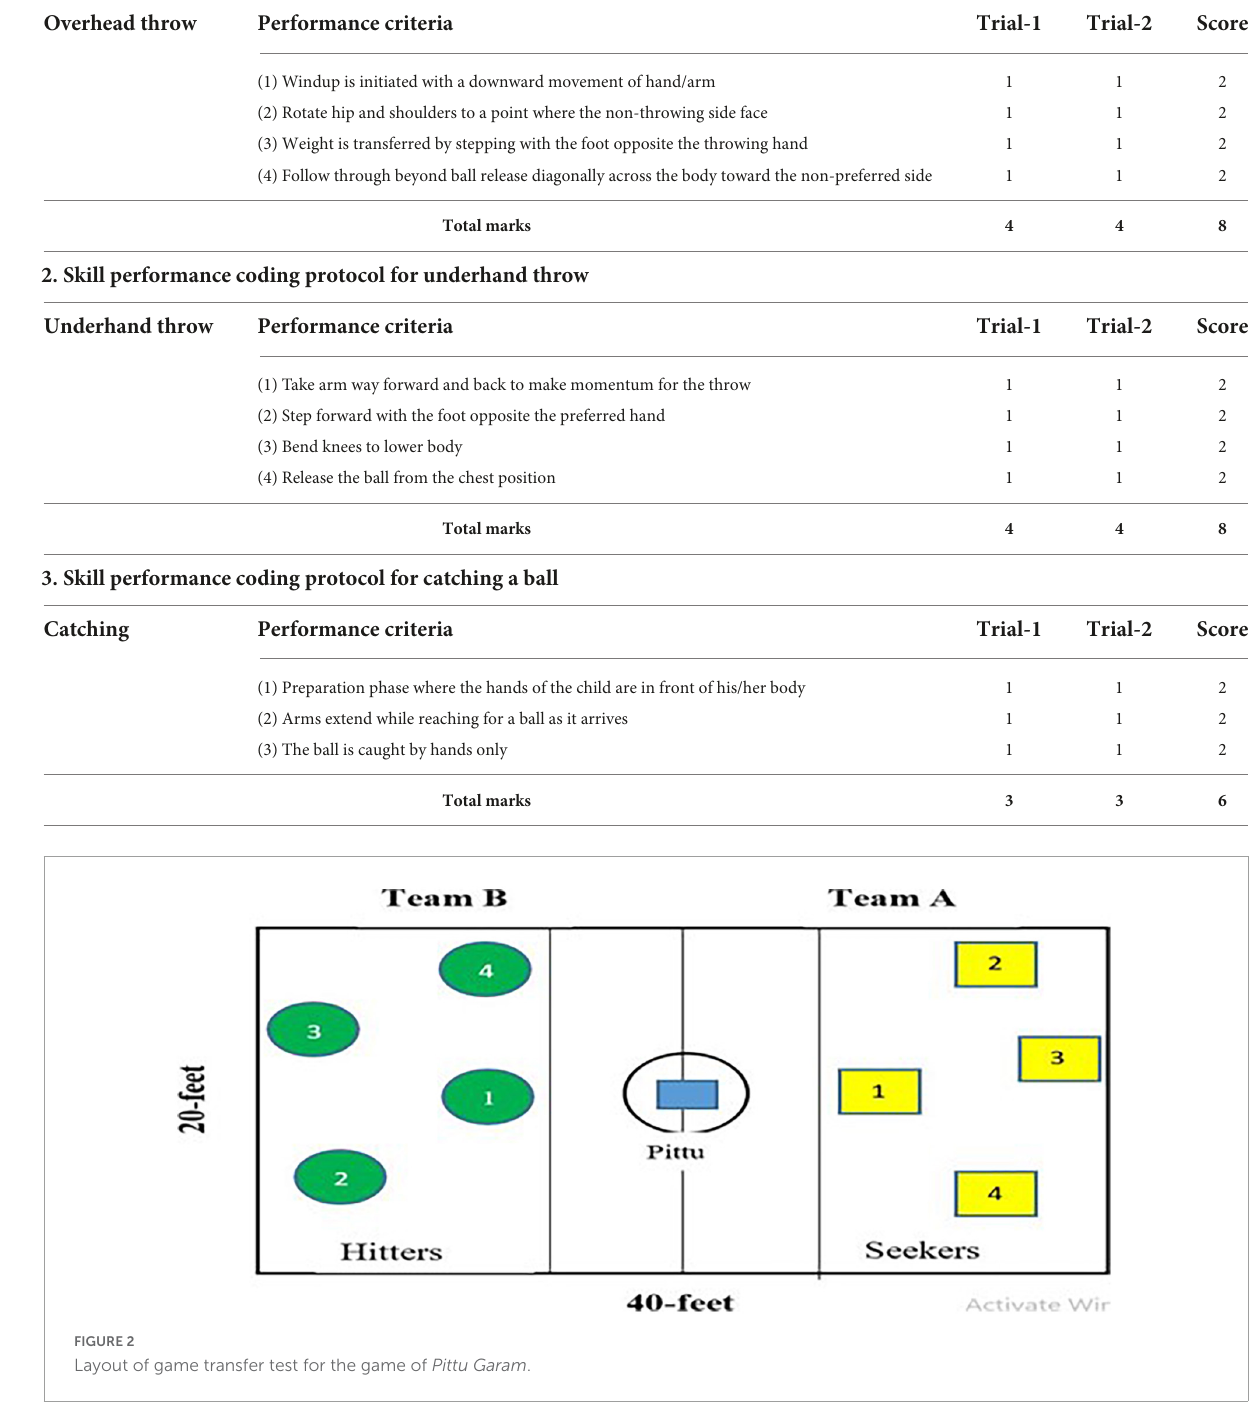
had a significantly lower score than the other three groups. = 0.637. Follow-up ANOVAs were performed p = 0.000, η 2 Partial For the post-test, there was a significant difference between at each time point. For the pre-test, there was a significant groups, F (3, 53.69) = 19.00, p = 0.000, η 2 difference between groups at the start of the experiment, = 0.214. The GB group The R group (Mean = 33.96, SD = 2.19) had F (3, 99) = 8.959, p = 0.000, η 2 Partial